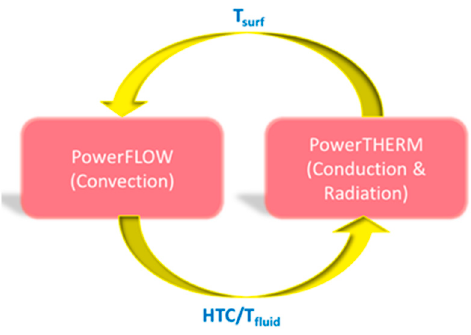
Figure 4. Scheme of the PowerFLOW – PowerTHERM coupling